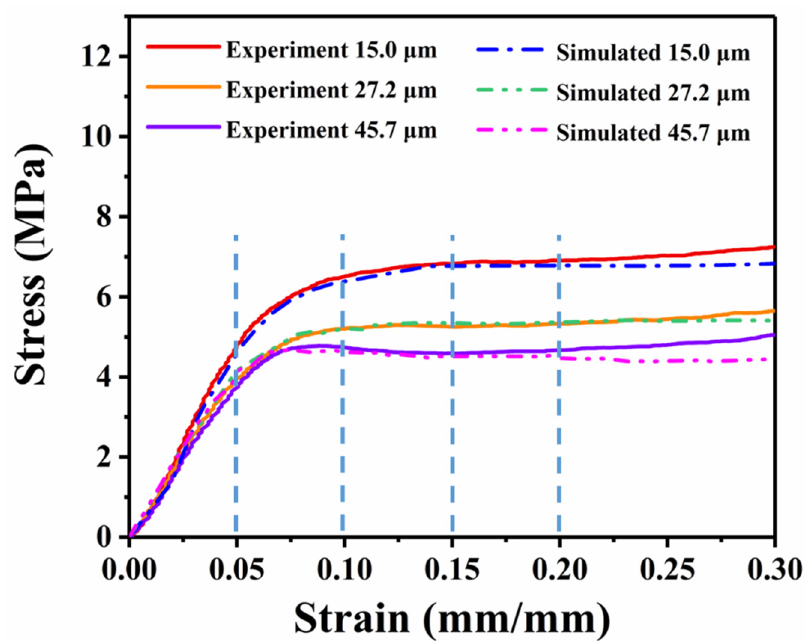
Figure 9. Normalized stress–strain curves of the experimental and simulated results of foams with the same porosity of nearly 82%.